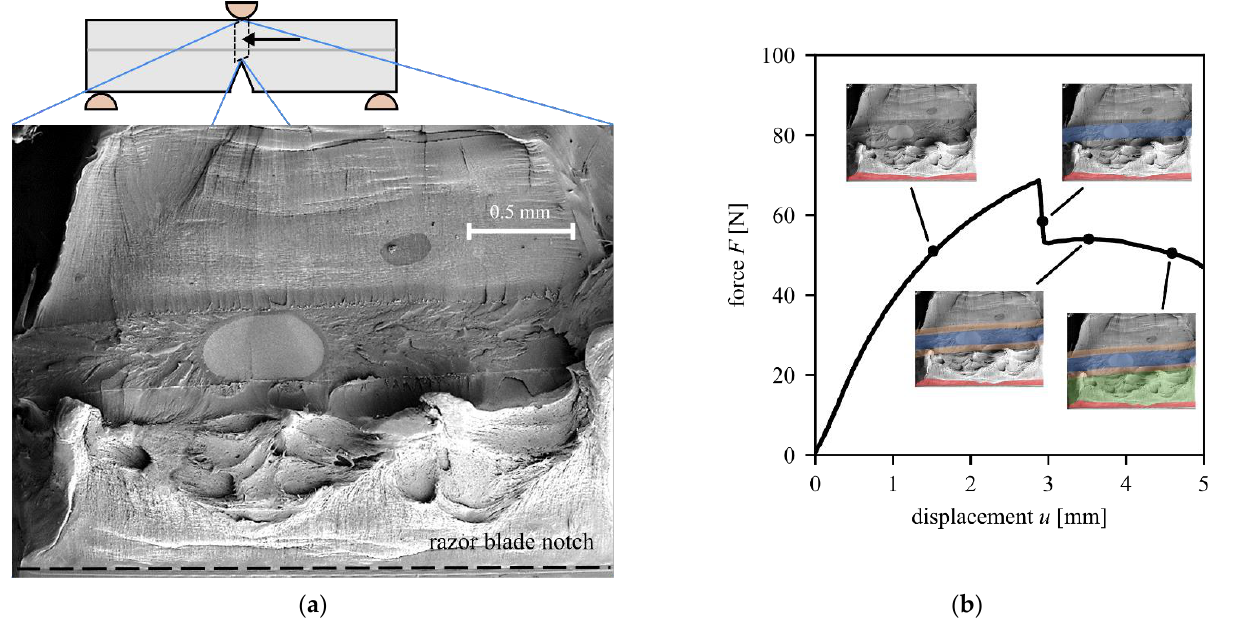
Figure 6. Experimental results of the SENB models with layered buildup: ( a ) fracture surface with distinct fracture regions and ( b ) force – displacement curve. The colored areas indicate the chronological order in which the fracture occurs on the specimen: red (crack tip blunting), blue (fracture of the EVOH layer), yellow (crack propagation from the EVOH layer), green (stretching and tearing of the remaining ligament between initial crack tip and fractured EVOH layer).